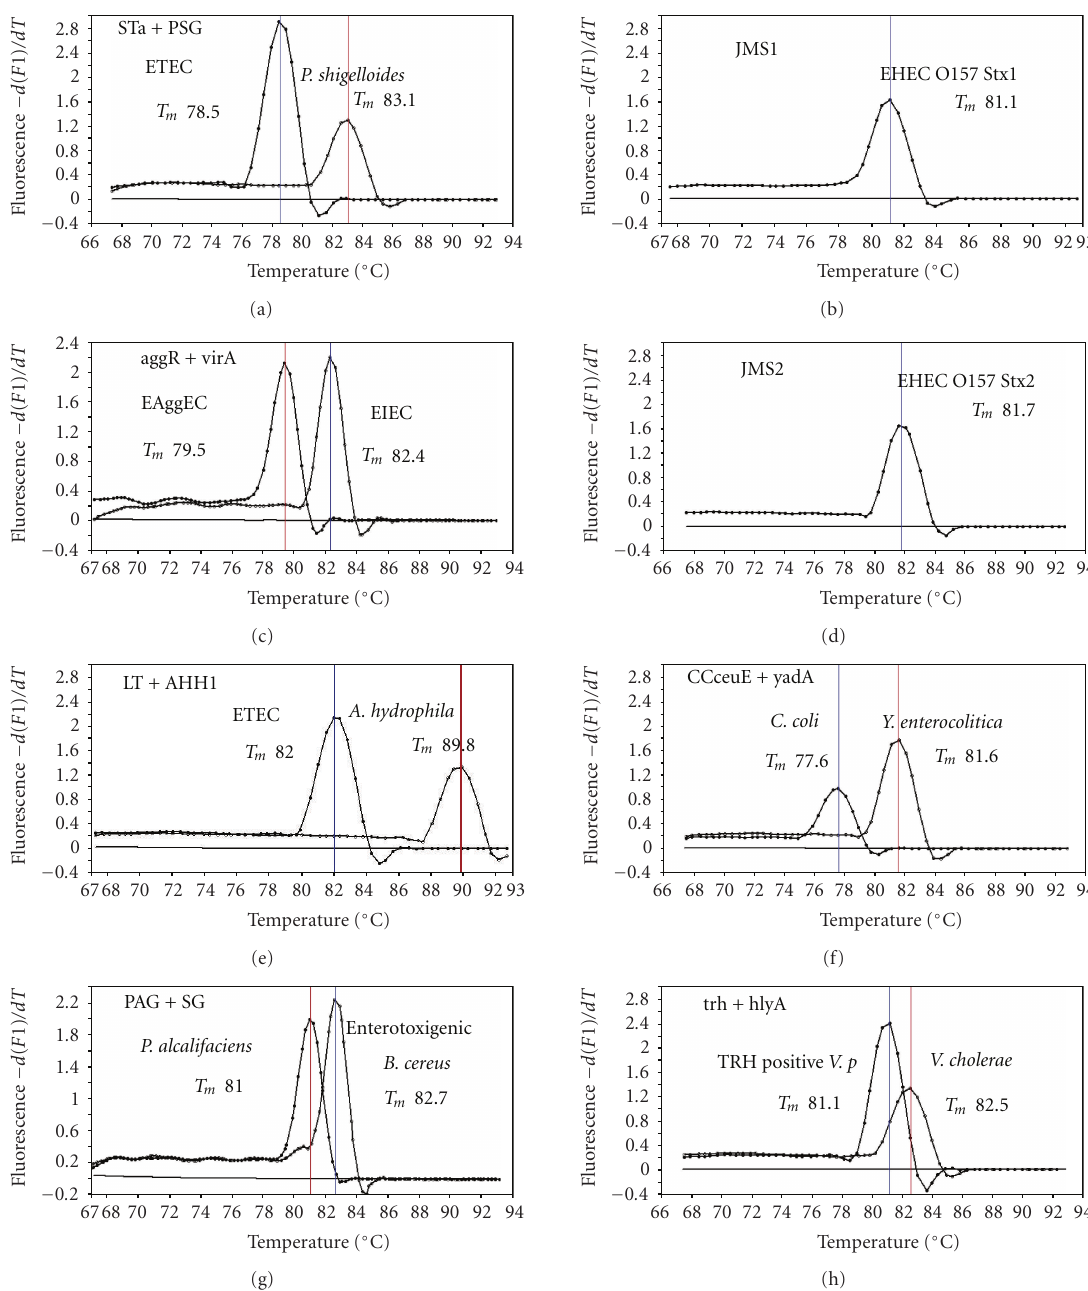
Figure 2: Melting curve analysis of duplex SYBR Green I PCR products in the second run using four primer sets: ST plus PSG, aggR plus virA, LT plus AHH1, and PAG plus SG; the third run using two primer sets: CCcesE plus yadA and trh plus hlyA; simple PCR with primers JMS 1 and